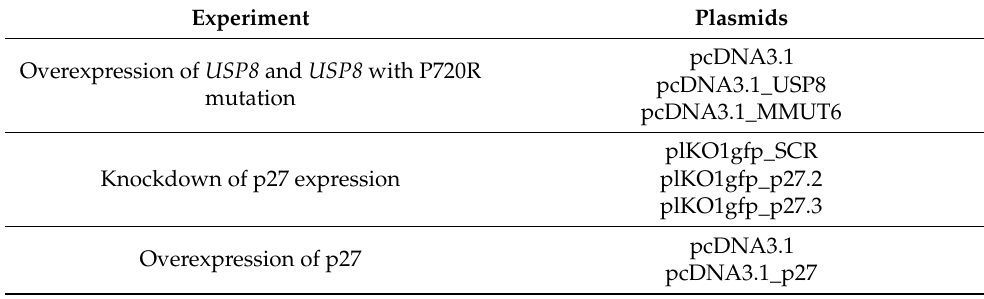
Table 3. Plasmids used for transfections.